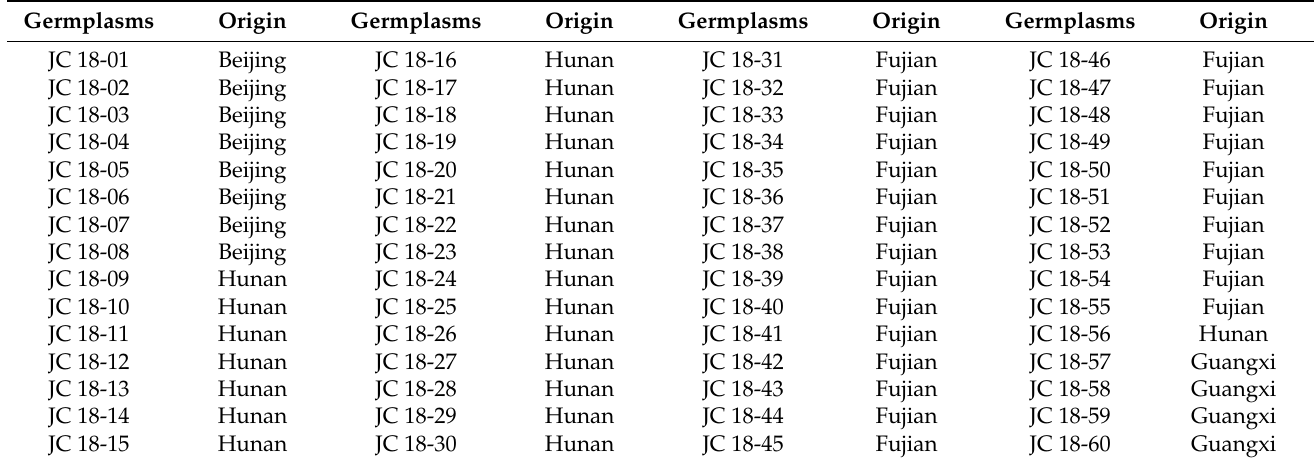
Table 1. The origin of all 60 leafy mustard resources.